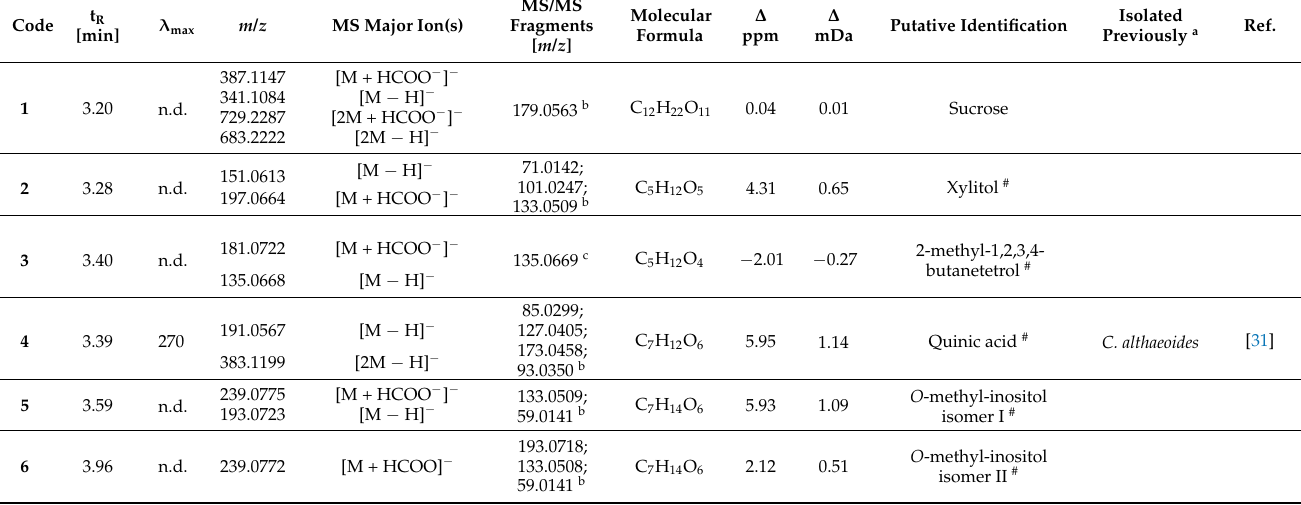
Table 1. Putative identification of chemical constituents present in C. arvensis extracts (ARE and ARM) by comparison of the MS 2 data (Negative mode,